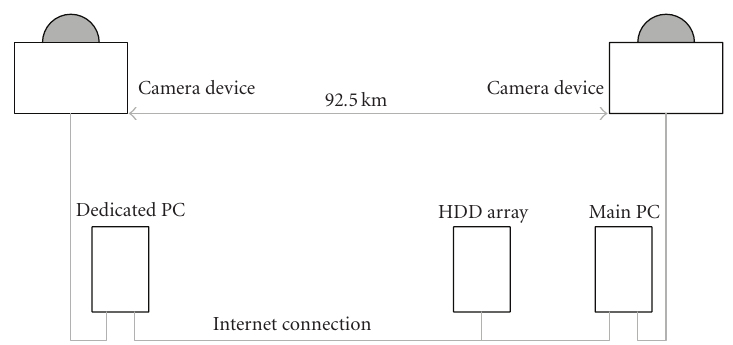
Figure 4: Configuration of the proposed system.